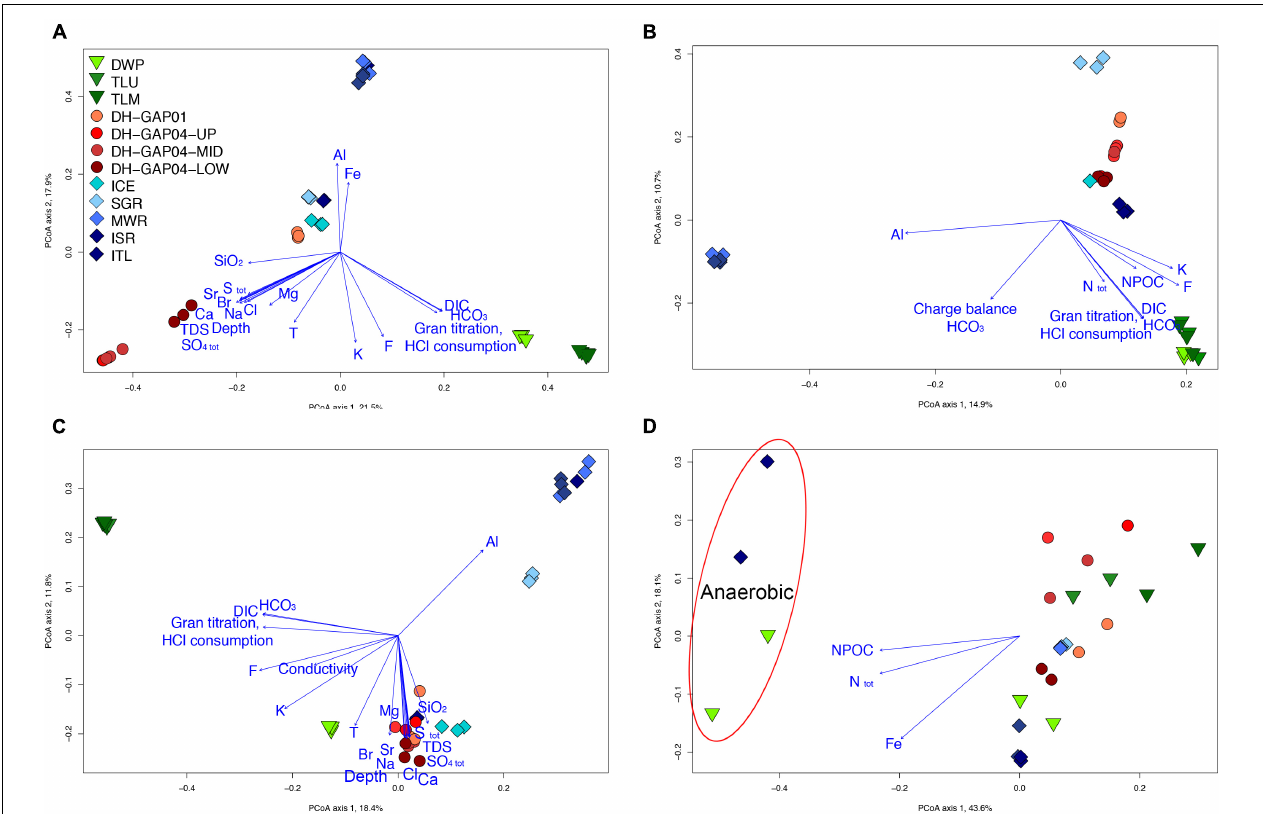
FIGURE 4 | Principal coordinates analysis plots of the (A) bacterial, (B) archaeal, (C) fungal communities, and (D) the hydrolysis patterns of substrates in the Biolog AN tests. The key to the samples in all figures is found in A . In D , the anaerobic Biolog AN tests are indicated with a red oval in the upper left quadrant. Only physicochemical parameters with p < 0.0001 (A–C) and p < 0.001 (D) were